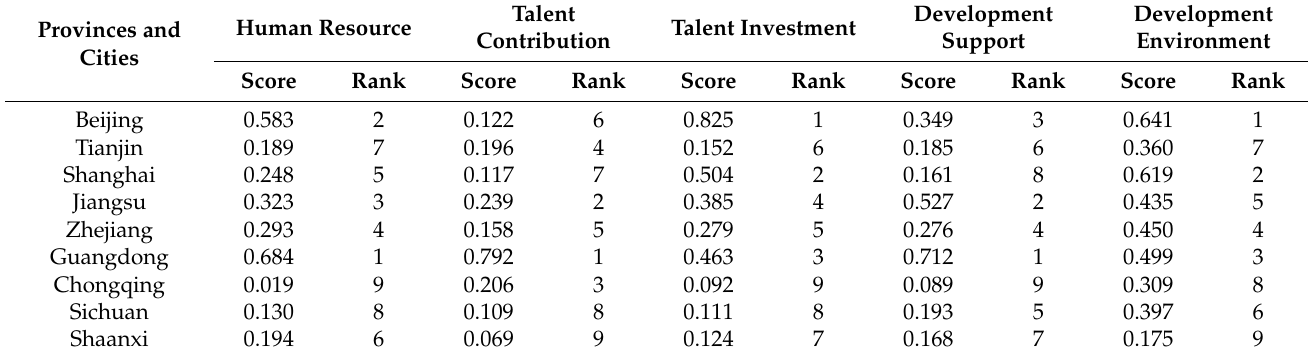
Table 7. Evaluation results of the talent competitiveness index of the intelligent industry.